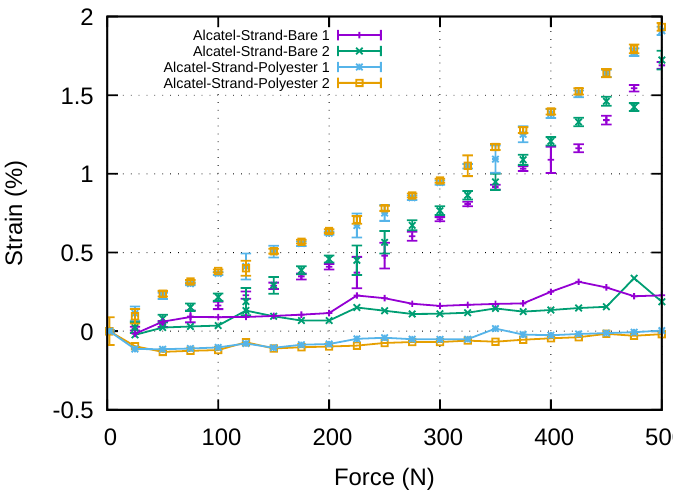
Figure 15. Strains measured by bare and coated fibre inside strap (points) and difference with the strain measured by the tensile testing machine